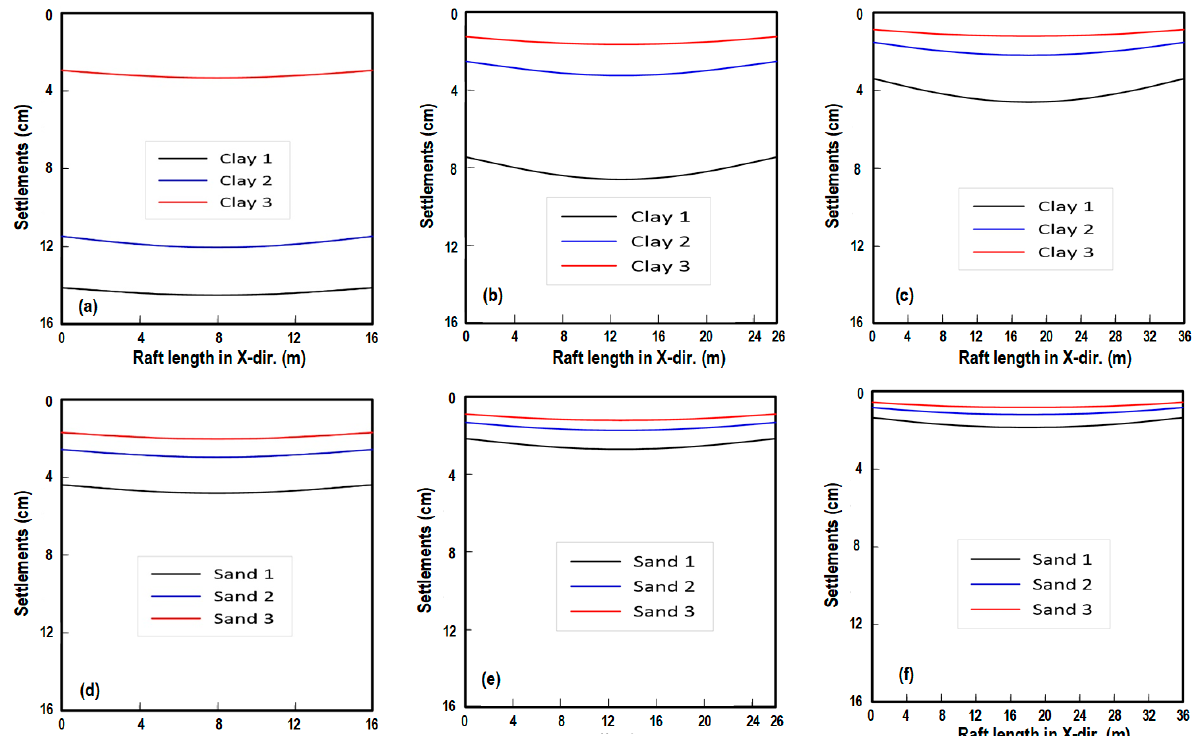
Figure 5. Foundation settlements obtained for square raft foundations with different dimensions: ( a ) 16 m, ( b ) 26 m, ( c ) 36 m in clays; ( d ) 16 m, ( e ) 26 m, ( f ) 36 m in sands.